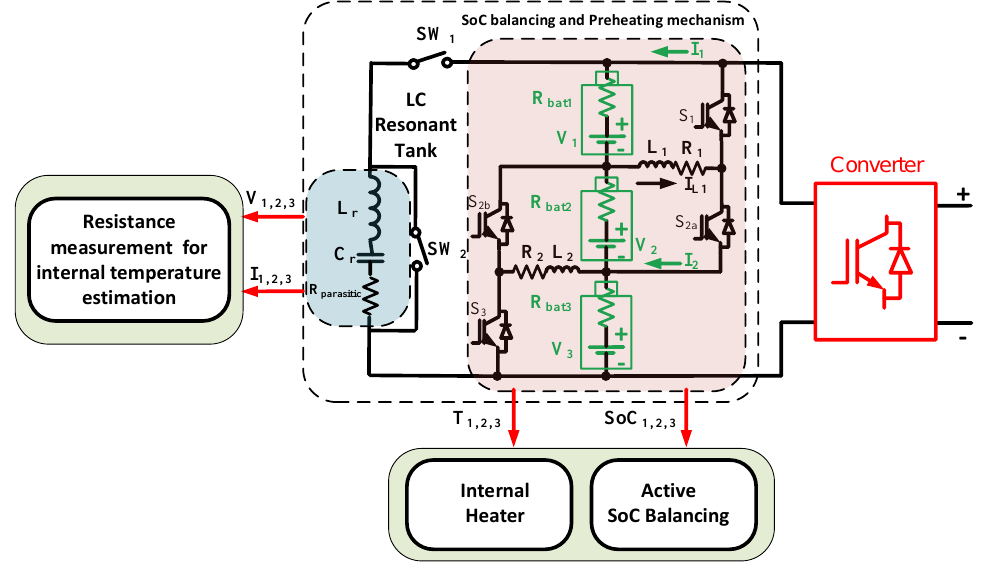
Figure 2. Proposed configuration for an LC resonant tank for BMS.